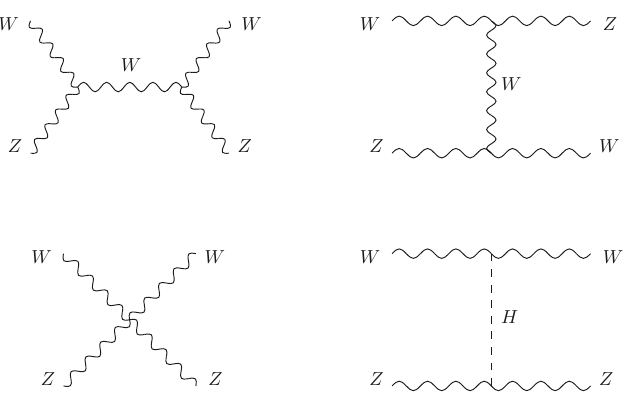
WZ ) SM amplitude in the SM at tree !